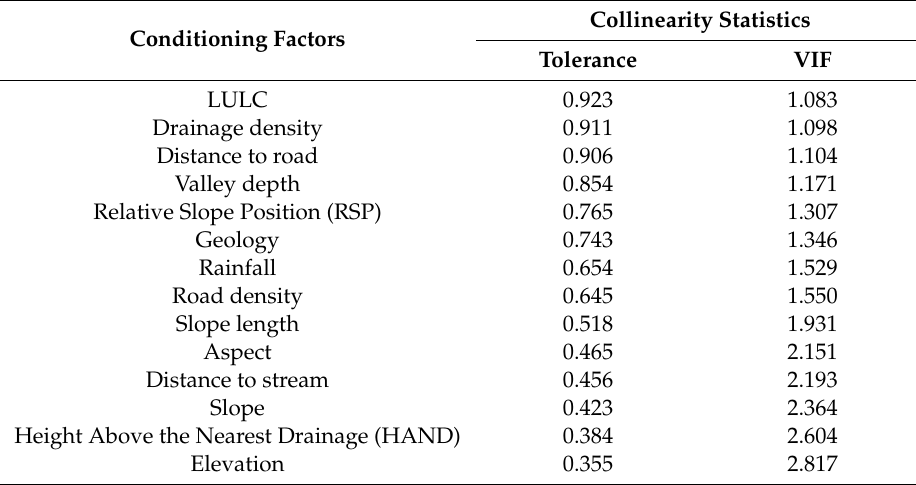
Table 3. Multi-collinearity analysis of the gully conditioning